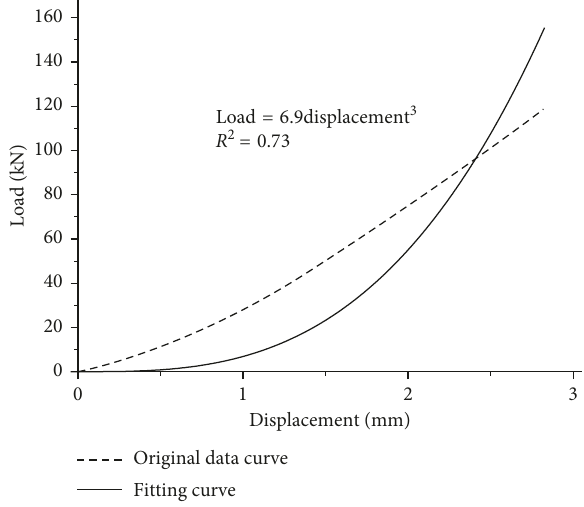
Figure 2: Stress-strain curve of the caved zone rock mass. Figure 3: Load-displacement curve of rock cores.